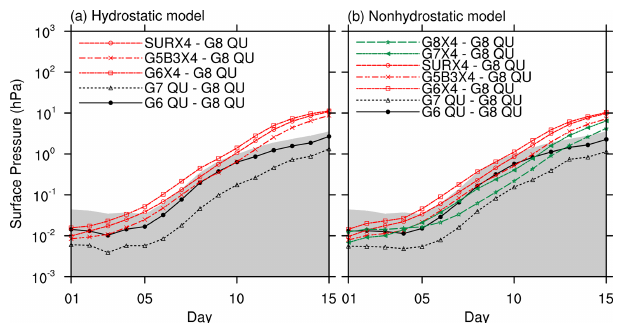
Figure 5. Baroclinic wave test. The l 2 error norms of surface pres- sure as a function of time for (a) the hydrostatic and (b) the non- hydrostatic dynamical core. The error is computed against the high- resolution quasi-uniform G8 mesh. The gray area denotes the uncer- tainty in the reference solutions, which selects the maximum l 2 er- ror norms from four curves (HDC and NDC at G7 and G8 as four cases). Details can be found in Jablonowski and Williamson